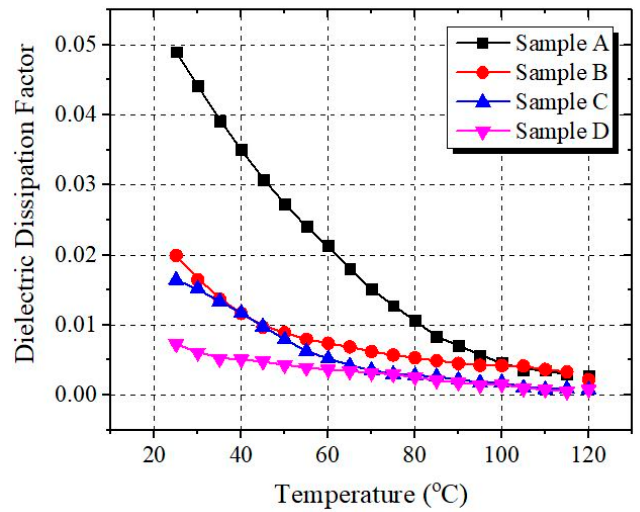
Figure 15. Dielectric dissipation factor of oil samples at various temperatures.